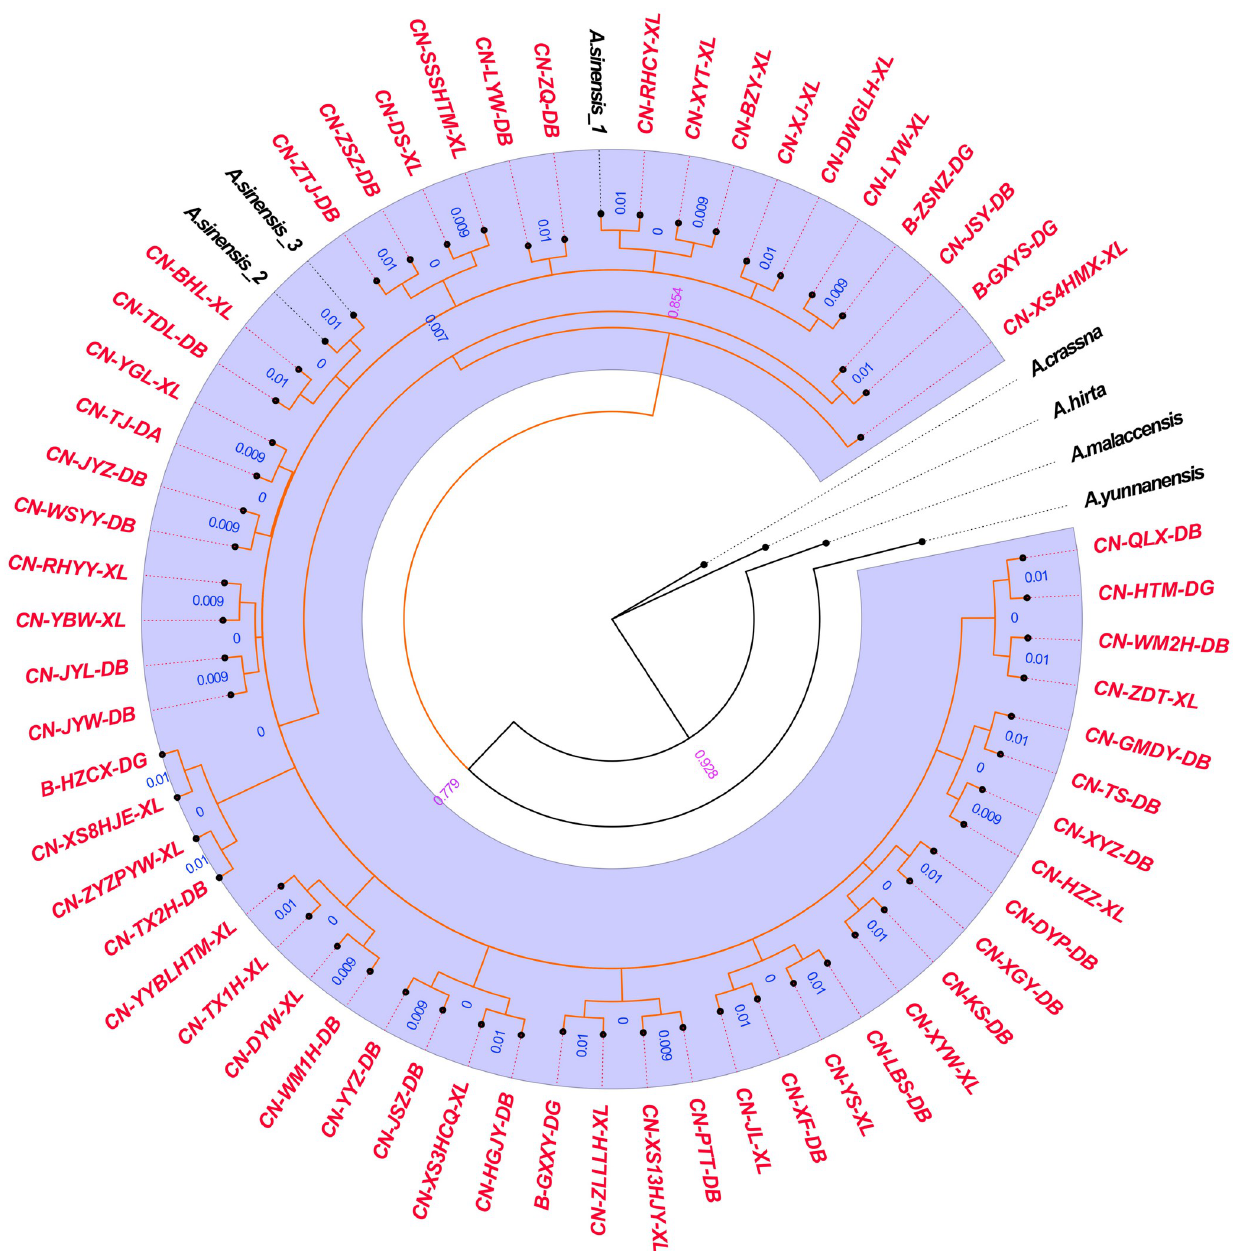
Fig 5. The phylogenetic tree of the 58 Qi-Nan germplasms and five Aquilaria species, constructed with Bayesian inference and the ITS2 + matK combination.